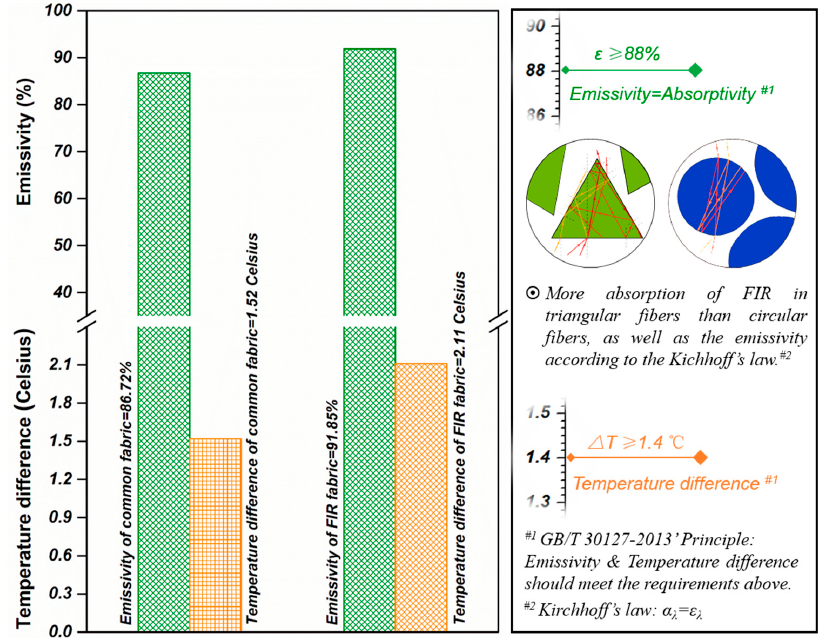
Figure 4. The emissivity and temperature difference of common fabric and FIR fabric. α means absorptivity, ɛ means emissivity.